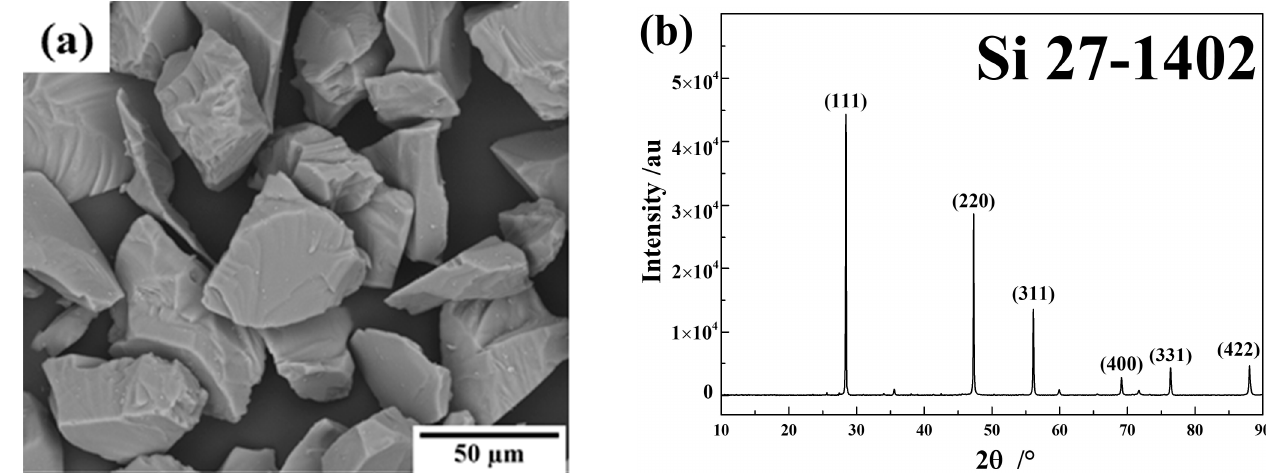
Figure 1. Surface morphology ( a ) and XRD ( b ) of the Si powder.